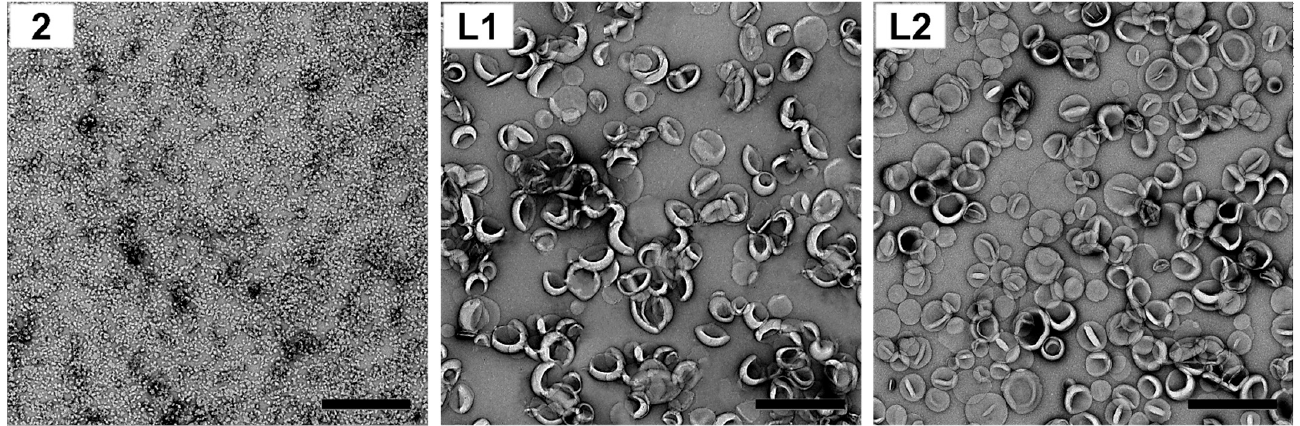
Figure 2. Particle images showing the morphology of compound 2 and encapsulated liposomes, liposomes L1 and L2 , captured by TEM (bar = 500 nm).